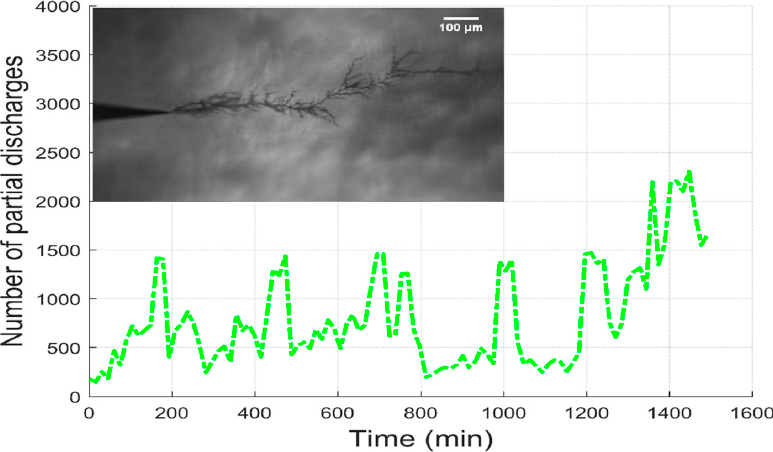
Figure 14. Partial discharge activities of ET growth under polarity reversal for case (III) in Table 4.